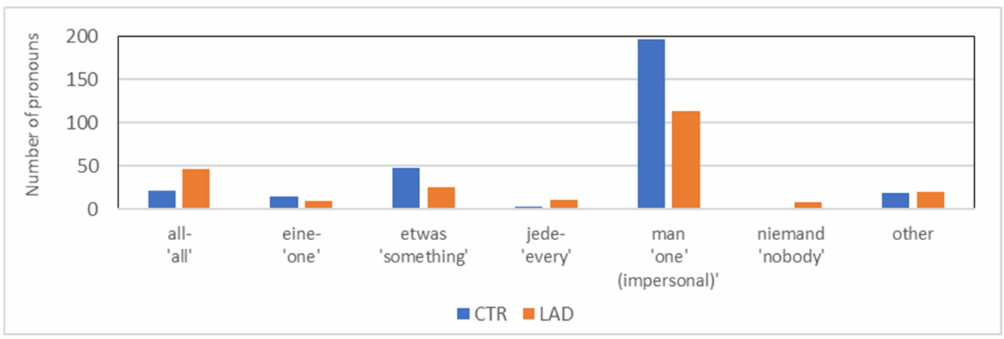
Figure 6. Types of indefinite pronouns in the CTR group and the LAD group.